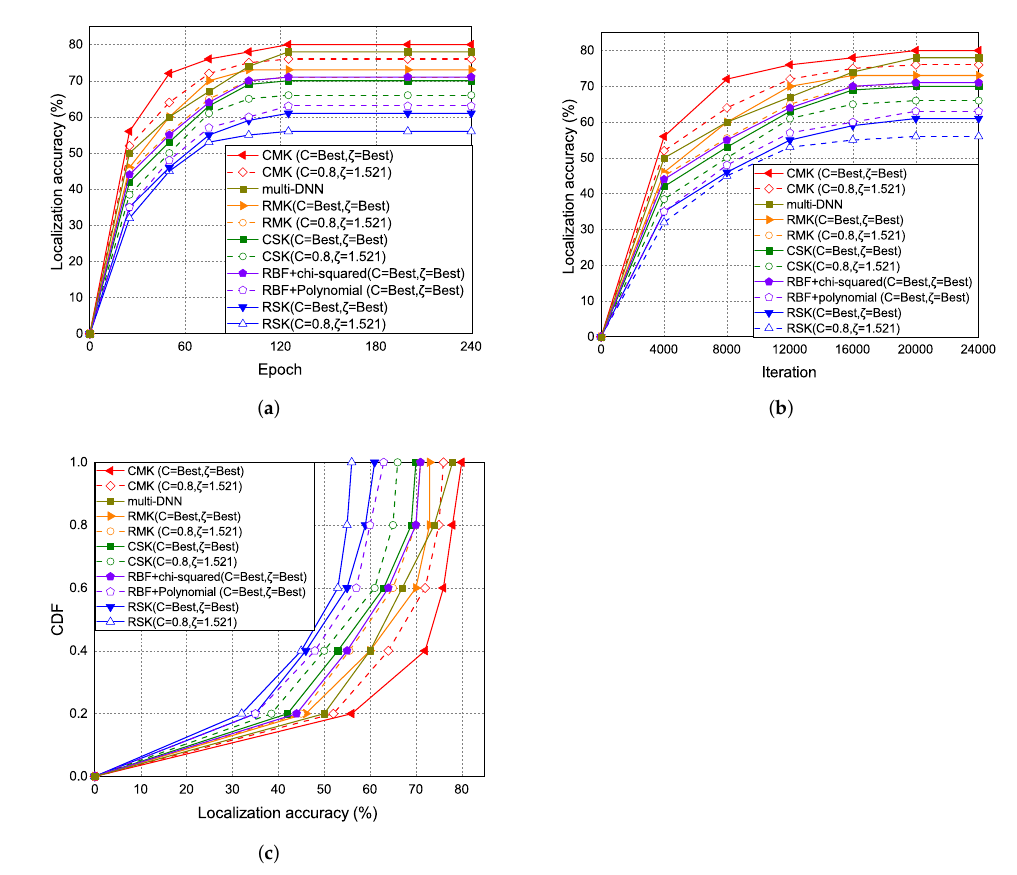
Figure 12. ( a ) Localization accuracy vs. epoch. ( b ) Localization accuracy vs. iteration. ( c ) Localization error vs number of selected APs with epoch 80.